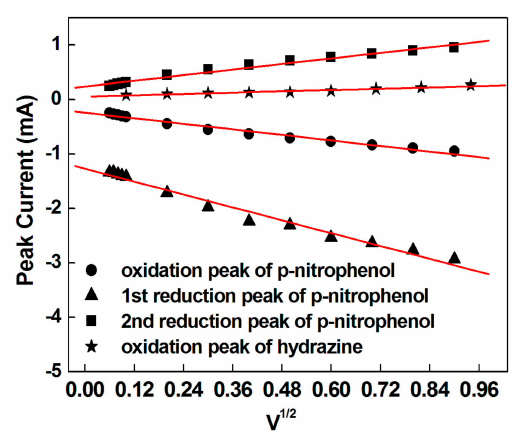
Figure 5. The linear dependence of peak current versus square root of scan rate for 1 mM hydrazine and